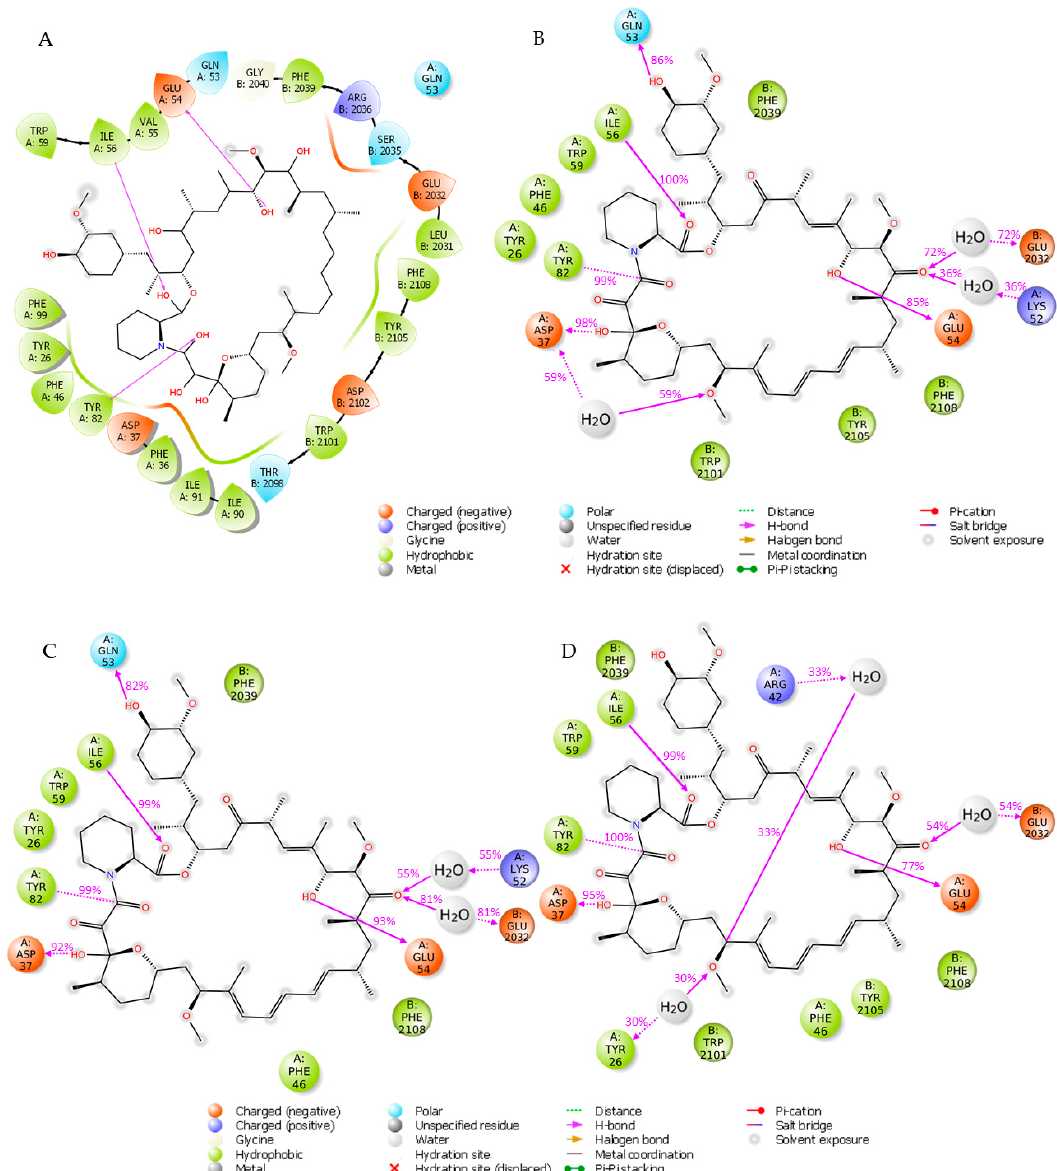
Figure 2. ( A ) Interactions between rapamycin and FKBP12 and FRB from the crystal structure (PDB code 1FAP). ( B ) Interactions occurring during the first MD simulation. ( C ) Interactions occurring during the second MD simulation. ( D ) Interactions occurring during the third MD simulation.